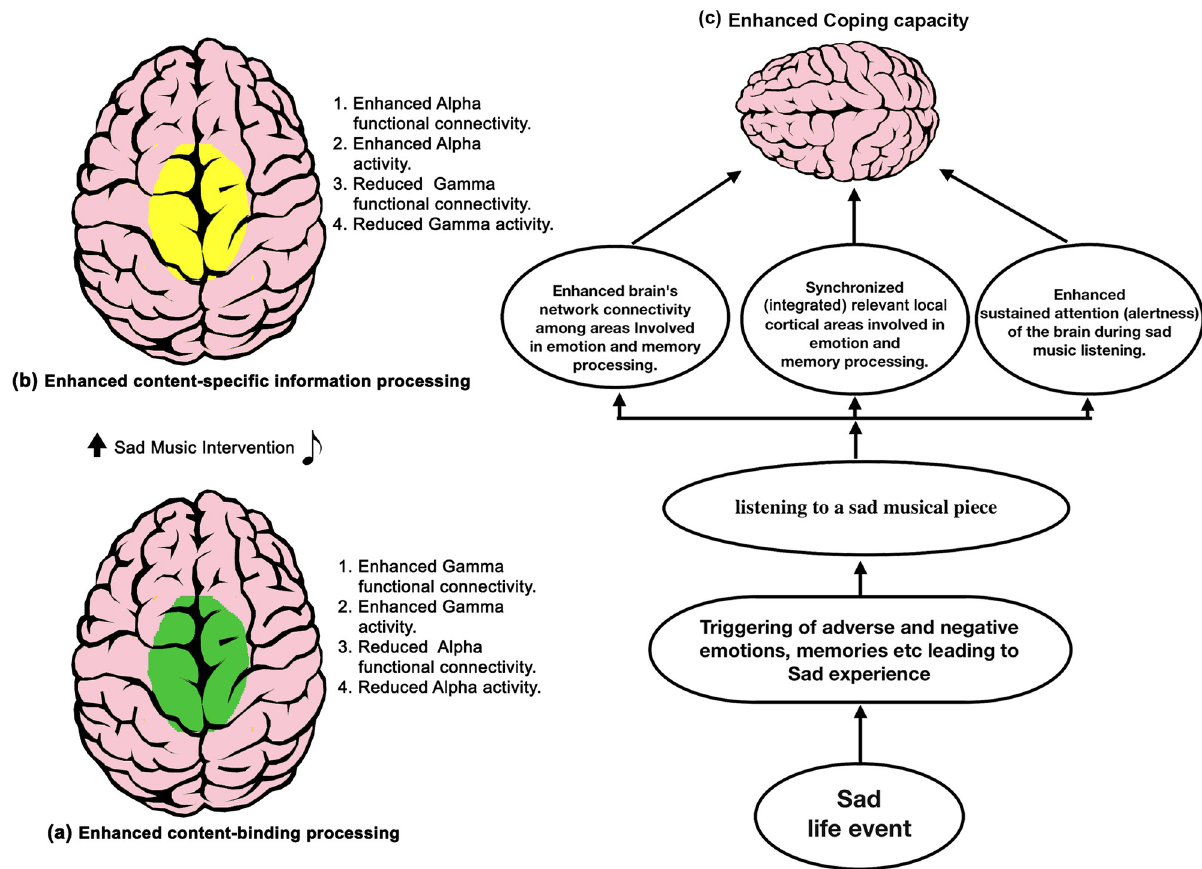
Fig 6. Schematic model. (a) Brain under SAR is characterized by enhanced functional connectivity and activity in gamma band, (Green colour) (b) Brain under sad music listening is characterized with enhanced coherence, and activity in the alpha band (yellow colour). (c) Potential neural mechanisms that boost up the coping ability in adverse circumstances are (1) enhancing functional connectivity of the brain, (2) enhancing local cortical integration (synchronization) of relevant areas, and (3) enhancing sustained attention (alertness) of the brain.